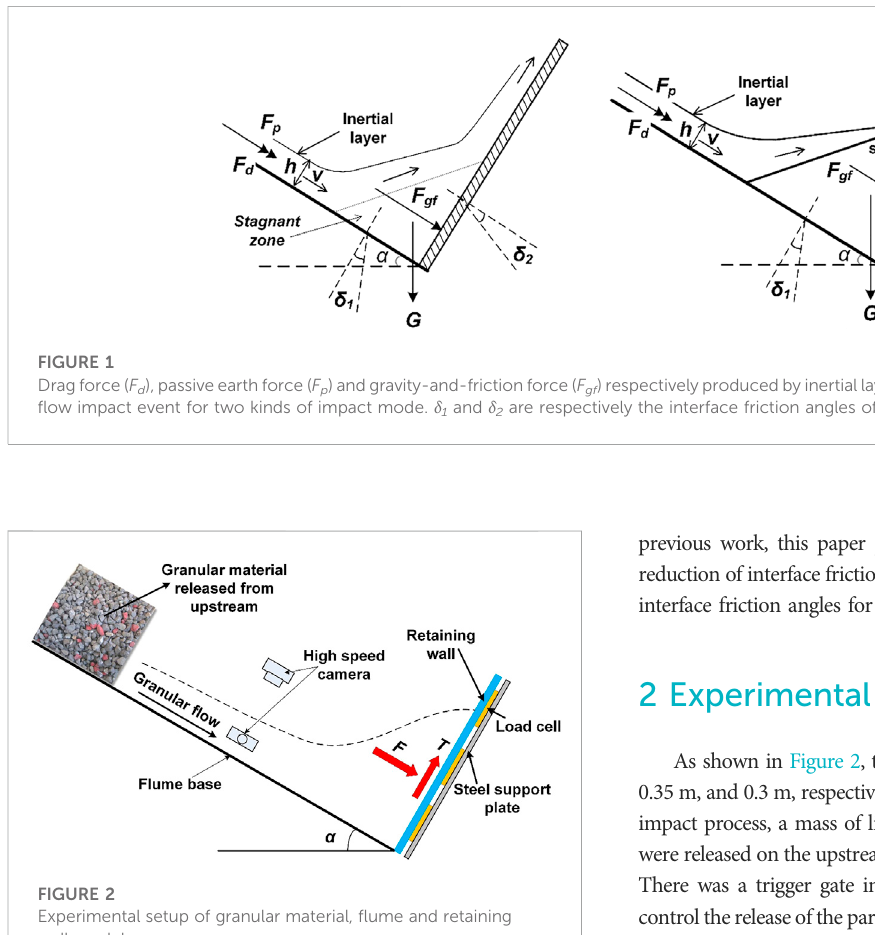
FIGURE 2 Experimental setup of granular material, fl ume and retaining wall